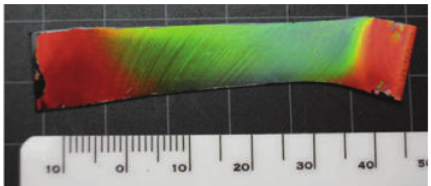
Figure 8: Structural color change in a crystal film after mechanical stress [37].